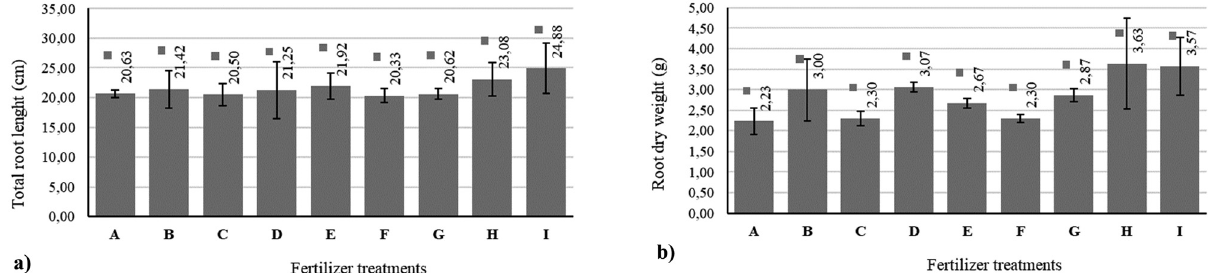
Figure 2: E ff ect of biofertilizer on total root length ( a ) and root dry weight ( b ) of nutmeg seedlings at 24 weeks after transplanting in the greenhouse. A: control, B: 0.15% BB foliar spray, C: 0.15% BB soil application, D: 0.3% BB foliar spray, E: 0.3% BB soil application, F: 0.5% MB foliar spray, G: 0.5% MB soil application, H: 1% MB foliar spray, I: 1% MB soil application. BB: bacillus biofertilizer, MB: mixed biofertilizer.